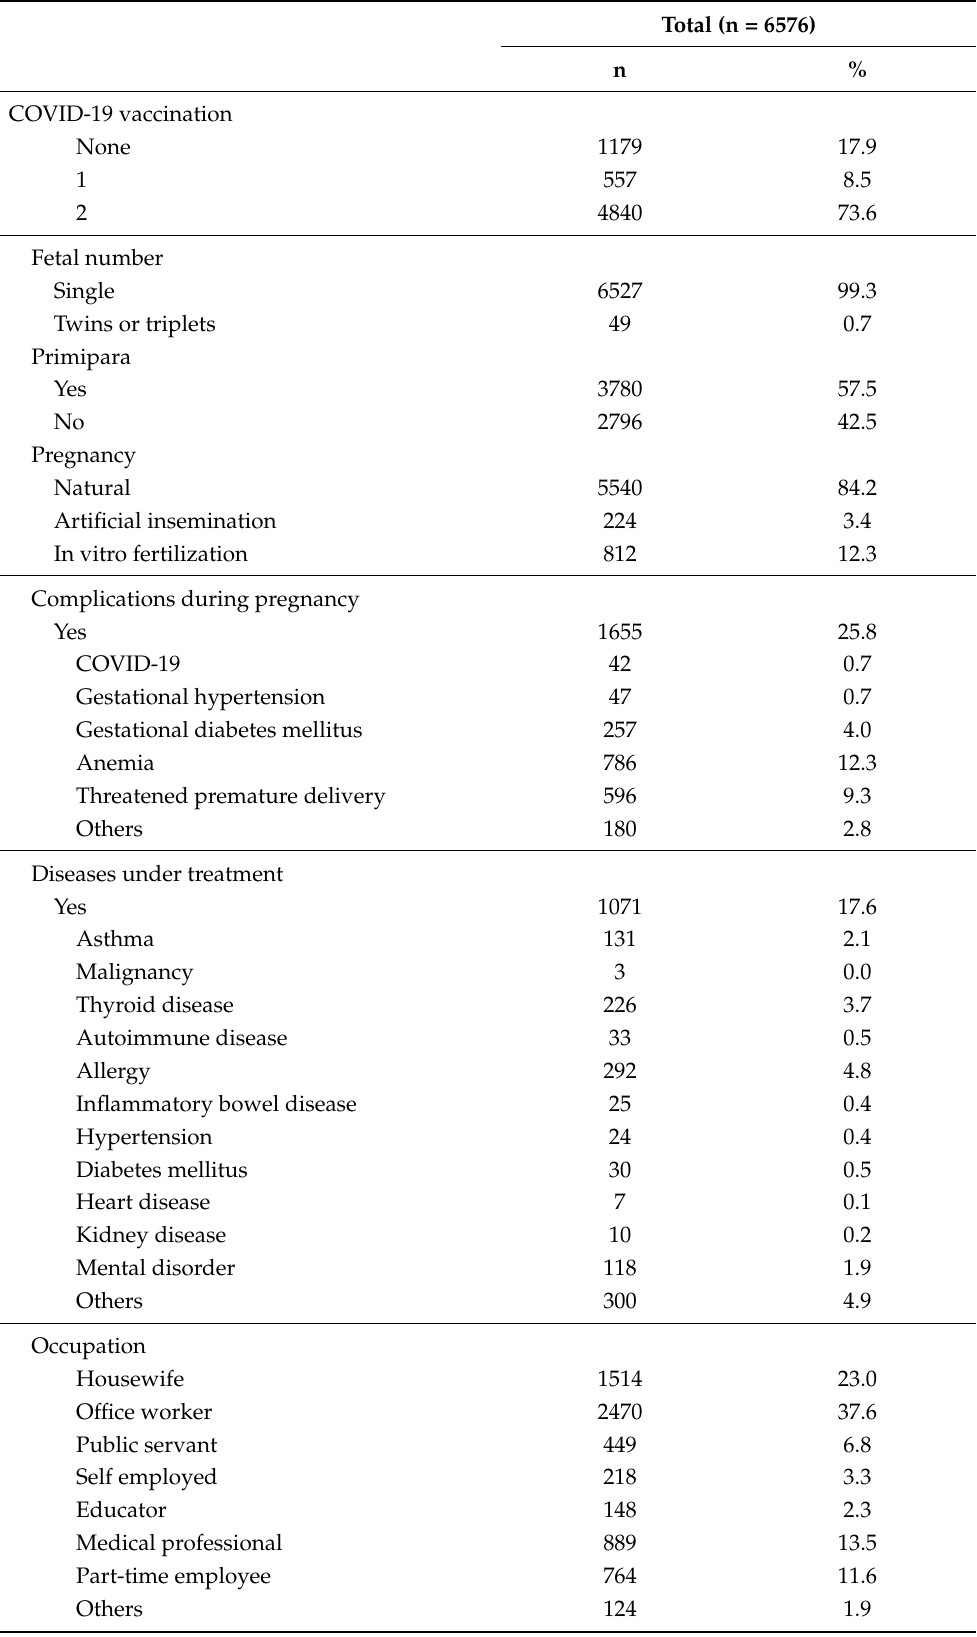
Table 1. Characteristics of the